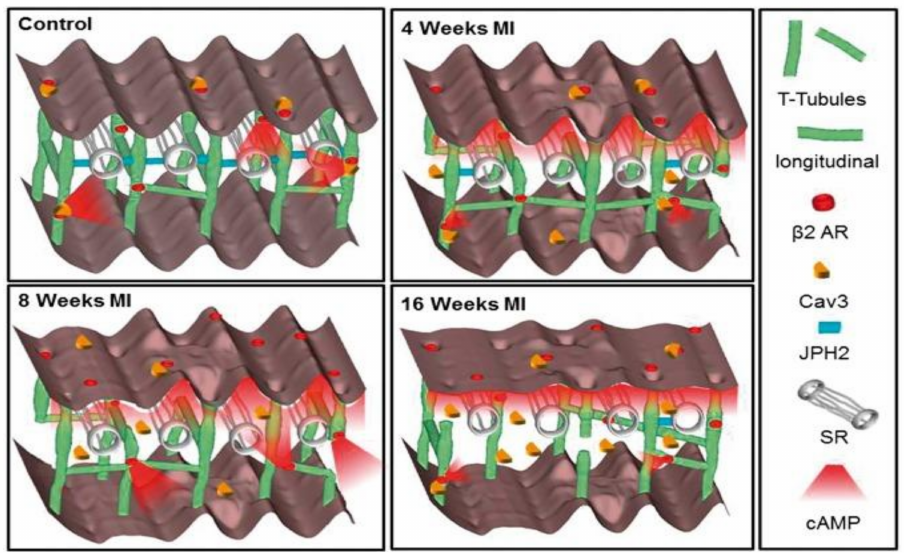
Figure 2. Progressive loss of the t-tubules and the increase of axial (longitudinal) elements of the TAT system demonstrate the change in cAMP signalling in the ventricular myocytes isolated from hearts with myocardial infarction (MI). Focus on the way in which β 2 -ARs are relocated and become more dispersed throughout the cell. As the disease progressively worsens, the loss of TAT structure deviates further and further away, but still attempts to generate signalling that keeps myocytes